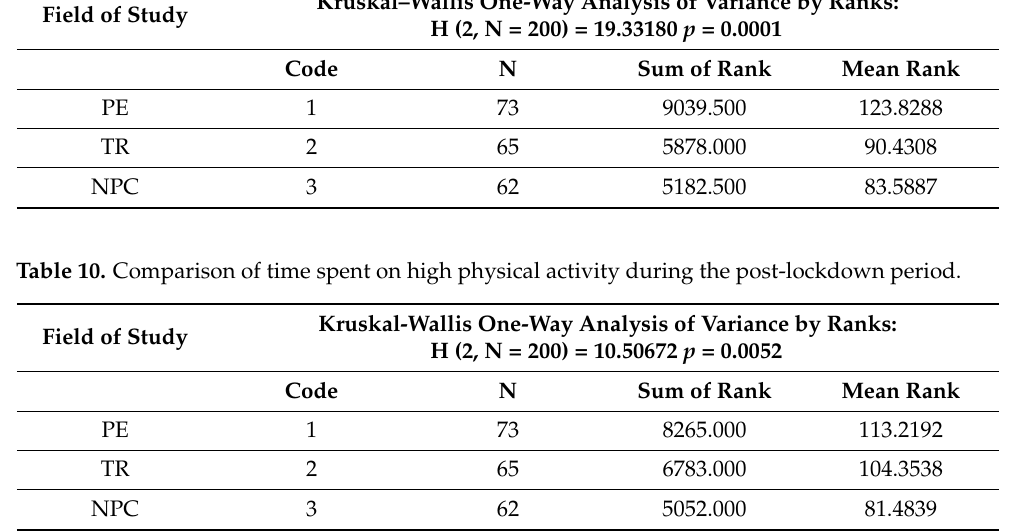
Table 9. Comparison of high physical activity measured in MET units during the post-lockdown period. Kruskal–Wallis One-Way Analysis of Variance by Ranks: Field of Study